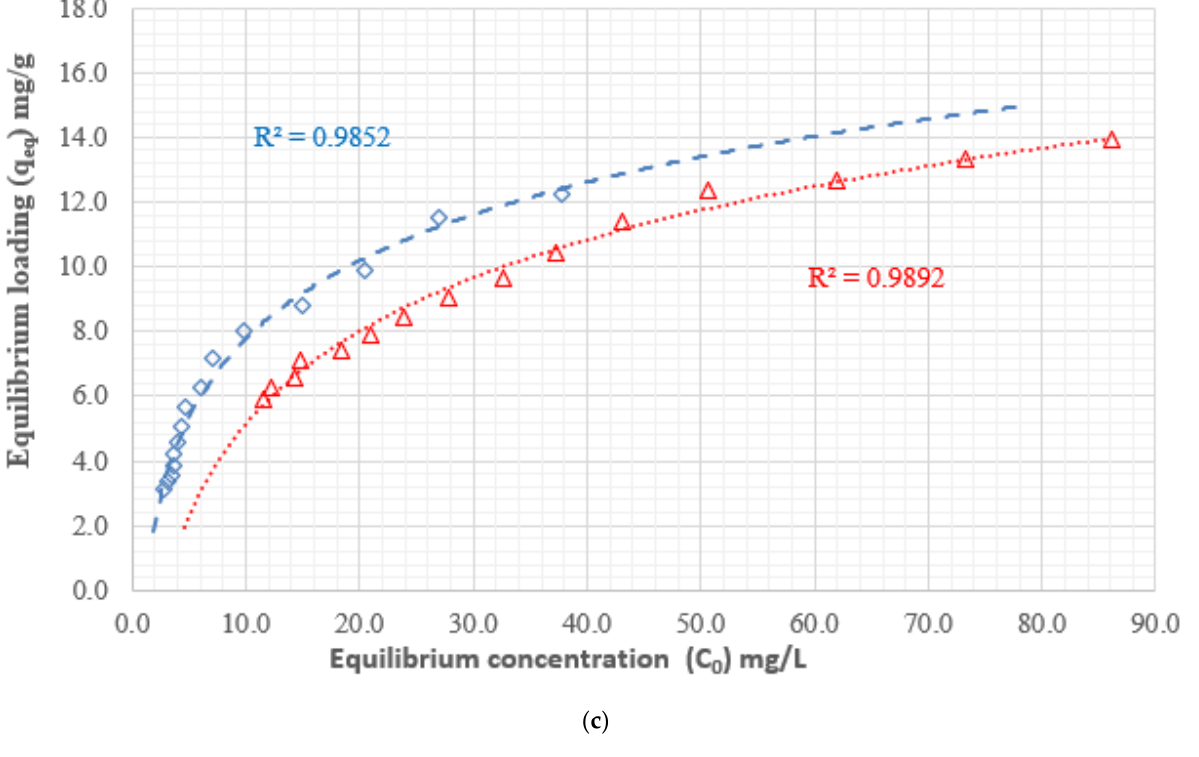
Figure 19. Adsorption isotherm for direct blue 78 dye removal using adsorbents ( a ) chitosan, ( b ) nanocellulose, and ( c ) CCMB-0.25:1.